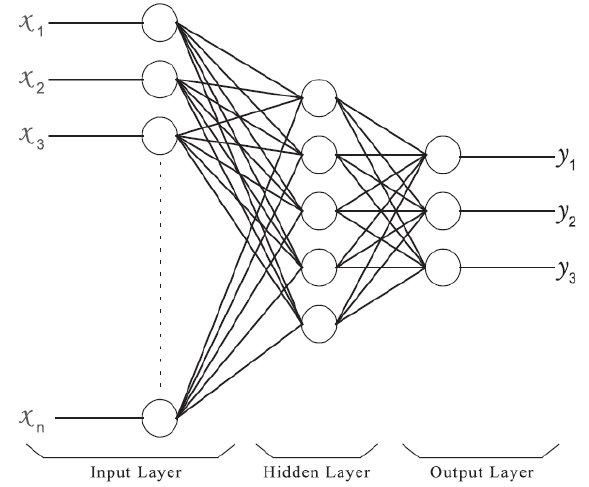
Figure 1. The structure of the MLPNN model (Orhan et al., 2011) There is no way to determine the number of neurons in the hidden layer. Therefore, the number of neurons is selected only by trial and error. If the network does not converge to the desired value, the number of hidden layer neurons are increased (Kocyigit et al., 2008, Subasi, 2005). Perceptron neural network training is based on the backpropagation algorithm. The weights in perceptron neural network training are adjusted in a way that the error between the desired output and the output is reduced. The values of the main inputs are actual values, where our